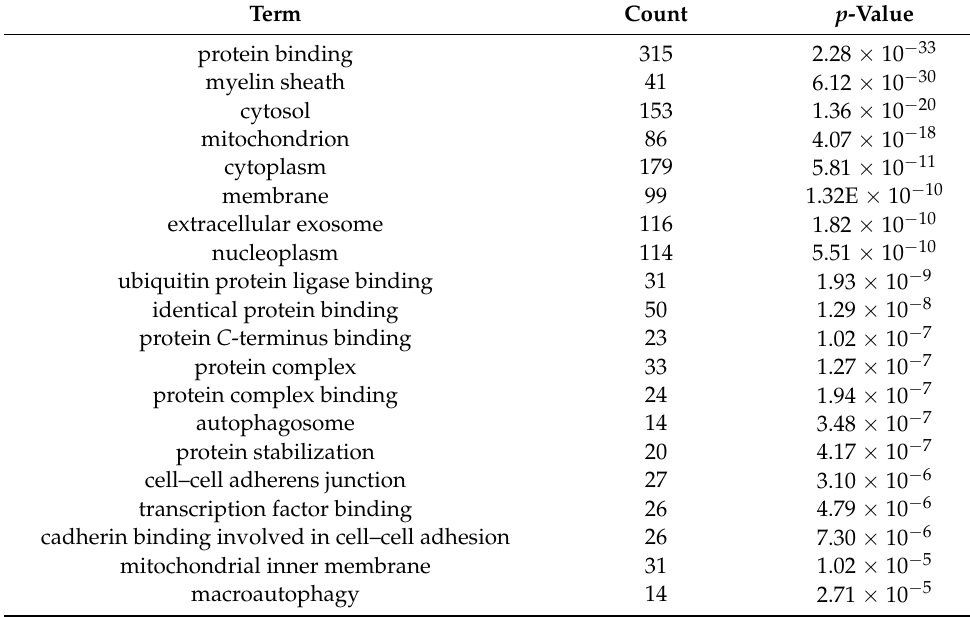
Table 1. Gene Ontology terms enriched in 402 human